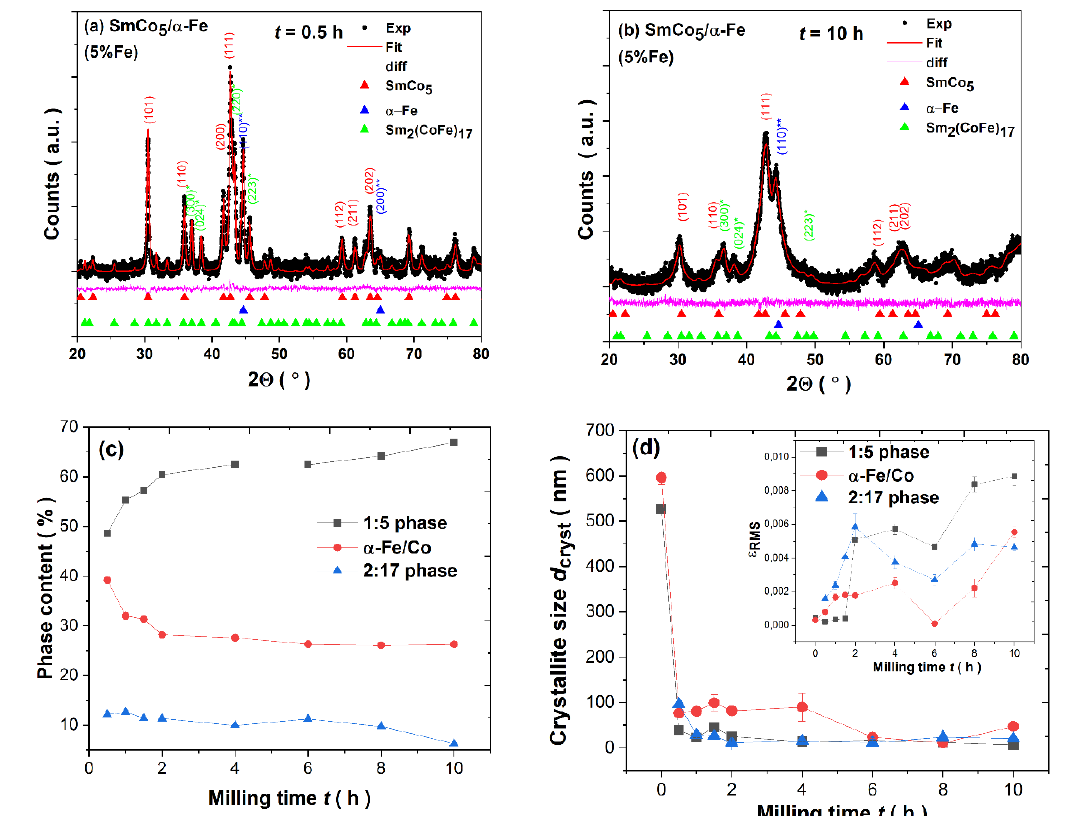
Figure 2. ( a ) Rietveld refinement of XRD pattern for SmCo 5 /α-Fe (5%wt. of α-Fe) powders milled for ( a ) t = 0.5 h; ( b ) t = 10 h. ( c ) The phase content of 1:5, α-Fe/Co and 2:17 phases, and ( d ) variation in crystallite size d cryst and lattice strain ε RMS (insert) over t milling time. Table 1. Crystal structure parameters determined from Rietveld refinement of XRD pattern for SmCo 5 /α-Fe (5%wt. of α-Fe).